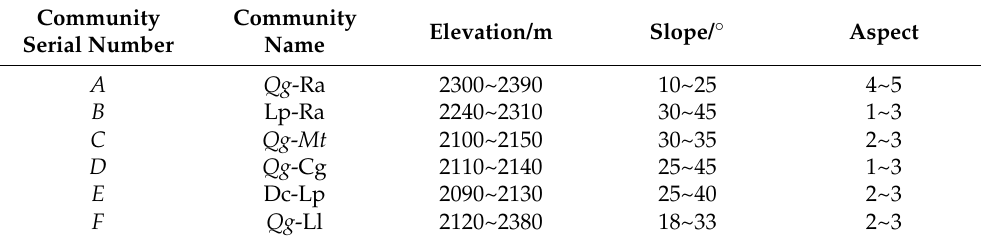
Figure 6. TWINSPAN quantitative classification of vegetation samples after fire (D: classification level, N: the total number of quadrats, the numbers in the rectangular boxes are the serial numbers of the samples). Table 2. Different community types and environmental characteristics of burned areas (Aspect: the larger the number, the drier and hotter the conditions; Qg: Quercus guyavaefolia H. Leveille; Lp: Lep- todermis potanini Batalin; Ra: Rabdosia adenantha (Diels) Hara; Er: Elsholtzia rugulosa Hemsl.; Mt: Mon- ogramma trichoidea J. Sm.; Aa: Artemisia argyi H. Lév. & Vaniot; Cg: Cymbopogon goeringii (Steud.) A. Camus.; Dc: Duhaldea cappa (Buchanan-Hamilton ex D. Don) Pruski & Anderberg; Ll: Leontopodium leontopodioides (Willd.) Beauv.)